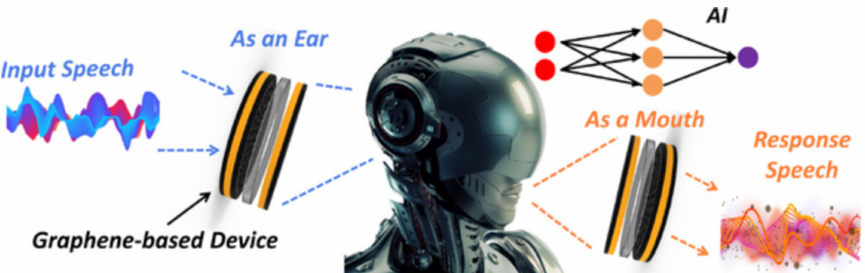
Figure 11. The machine learning-assisted dual-function acoustic HCI system. Reproduced with permission from [16]. Copyright 2022